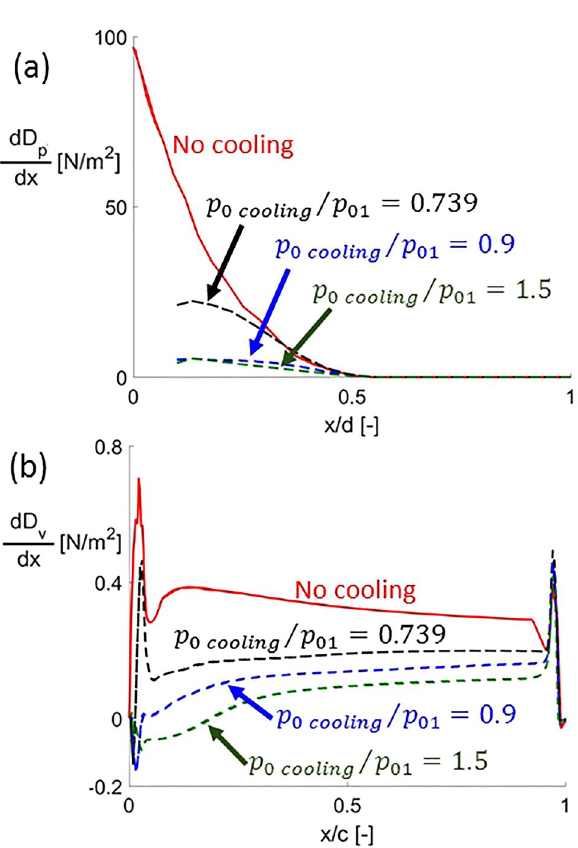
Figure 9. Local ( a ) pressure drag distribution near the leading edge and ( b ) viscous drag distribution along the airfoil wall without actuation and under different steady blowing